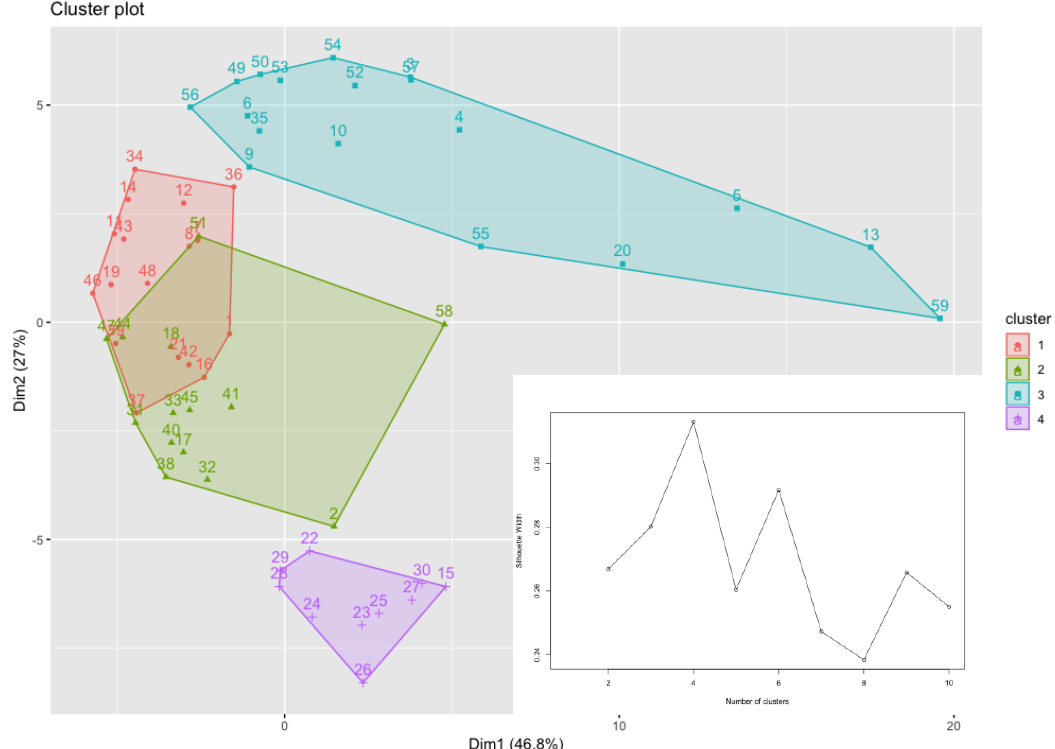
Figure 7. Clustering analysis applied to hematological data collected from all rats on day 15. Data points representing all rat samples are separated into four di ff erently colored clusters using k-Medoids clustering algorithm. Cluster 3 is composed of the control, CFA + indomethacin and some rats of CFA groups. Cluster 4 only includes rats belonging to CFA + Nigella sativa and CFA groups. Both groups treated with Nigella sativa oil are distributed in clusters 1, 2 and 3. The inset of the figure represents the average silhouette function indicating the optimal number of